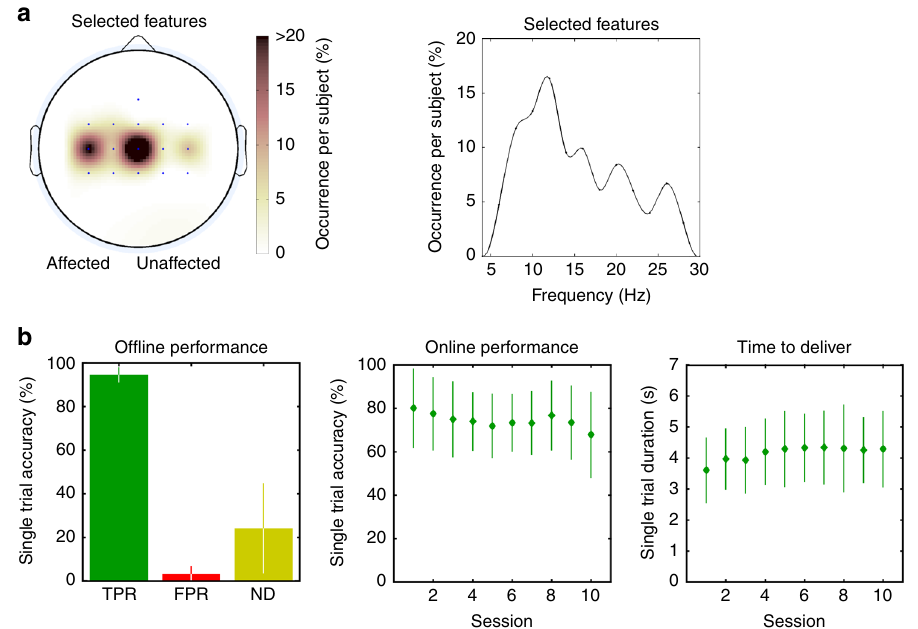
Fig. 3 BCI features and performance. For all subjects of the BCI – FES group ( N = 14): a Selected discriminant EEG features used for closed-loop control by their electrode location (the affected hemisphere is on the left side) and frequency distribution. b Left. Average of fl ine single-trial performance estimated in the calibration session (±standard deviation): true positive rate (TPR), false positive rate (FPR), and no-decision (ND). Center. Average online single-trial classi fi cation performance for each session (±standard deviation). Right. Average time required by the BCI to detect a movement attempt in each session (±standard